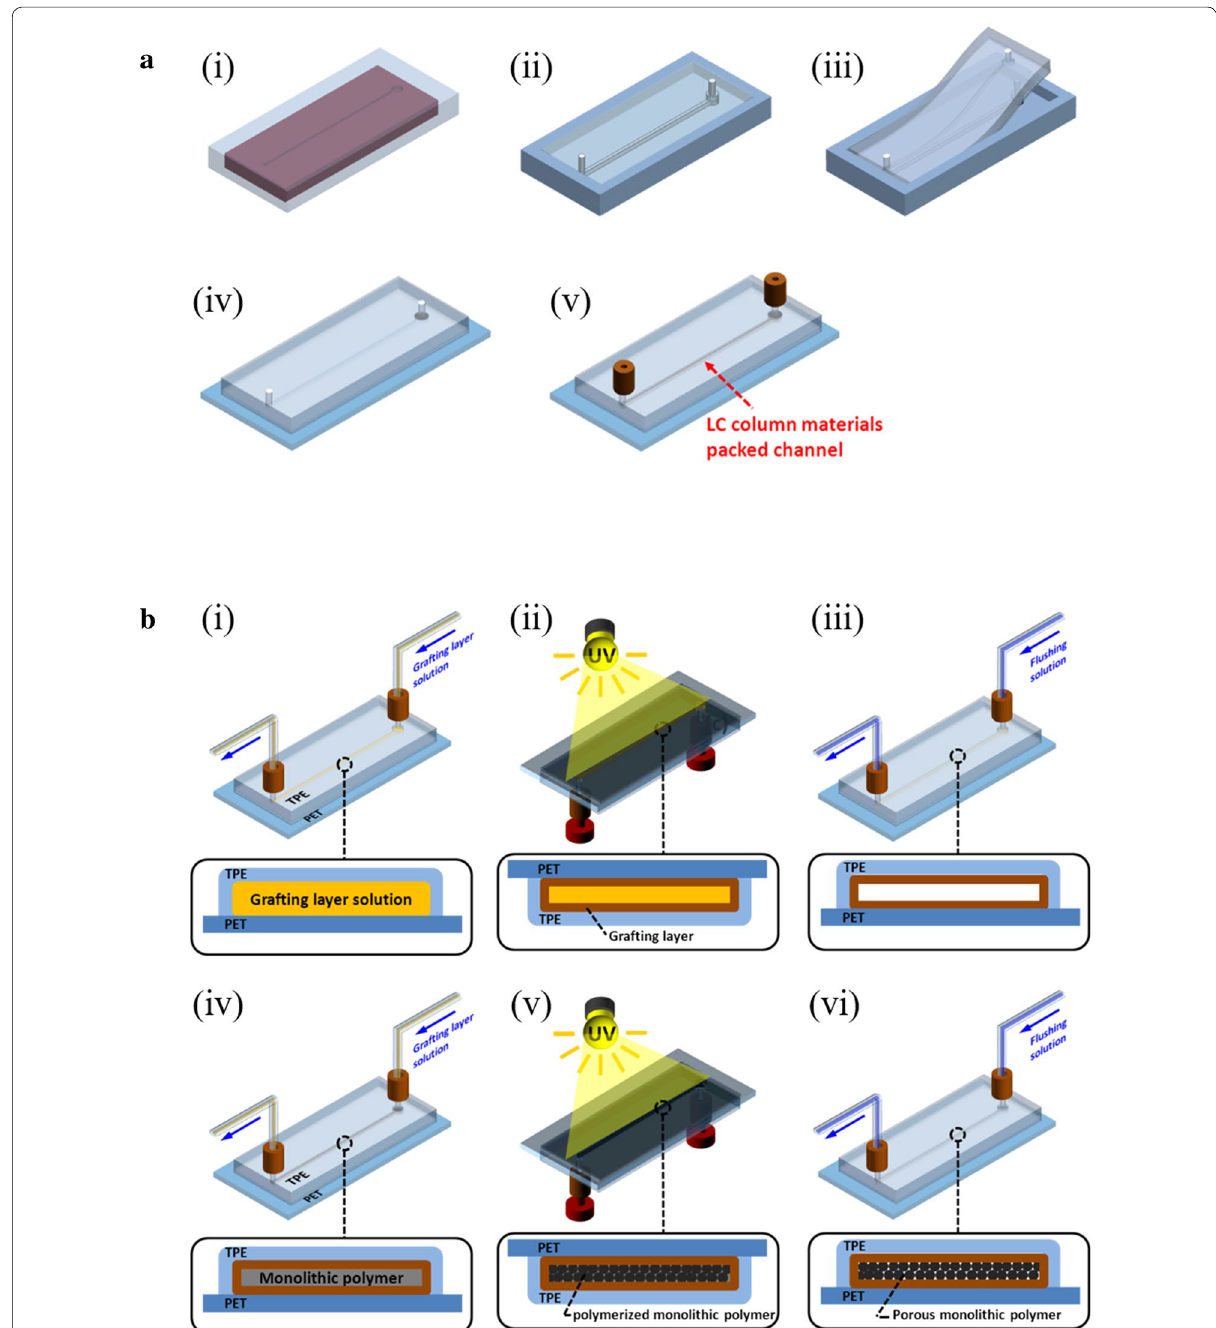
Fig. 1 Fabrication procedures of a TPE microfluidic device, (i) PDMS replica mould from the acrylate master mould, (ii) TPE pouring, (iii) peeling off the semi‑cured TPE, (iv) bonding with the PET substrate, (v) PEEK unions attachment and the channel packing with MNP, and b poly(methyl acrylate) monolithic column packing in the channel, (i) introducing a photografting solution into a TPE channel, (ii) UV exposure through PET substrate, (iii) flushing the residual solution by flowing a methanol‑based cleaning solution, (iv) introducing the poly(methyl acrylate) mixture solution, (v) UV exposure through PET substrate and (vi) flushing unreacted solutions using the cleaning